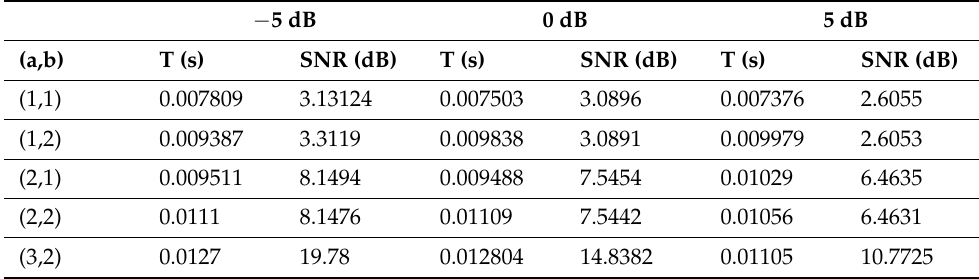
Table 3. Comparison between various wavelet decomposition levels in terms of execution time (T) and the corresponding SNR improvements generated at various input SNR